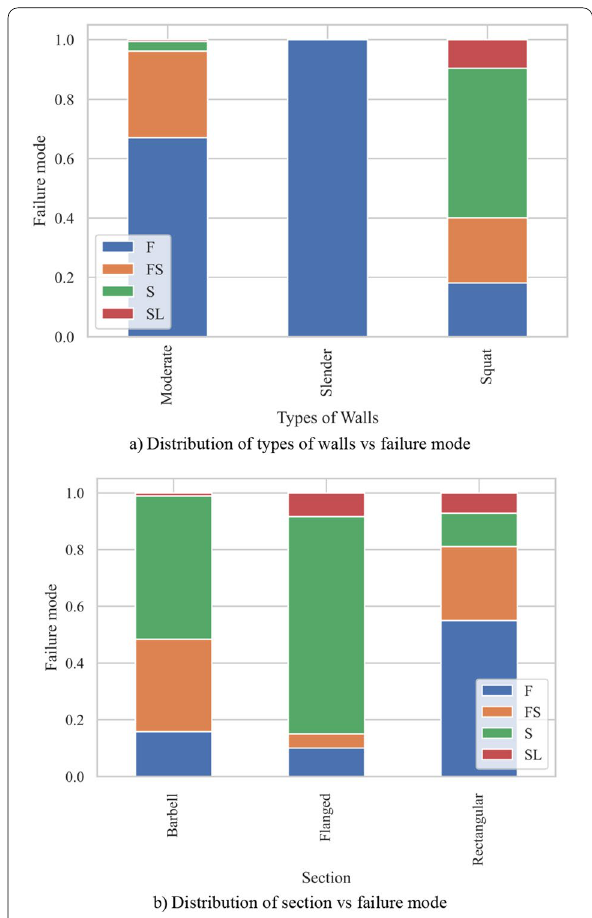
Fig. 2 Distribution of section/types of walls vs. failure mode. a Distribution of types of walls vs. failure mode. b Distribution of section vs. failure